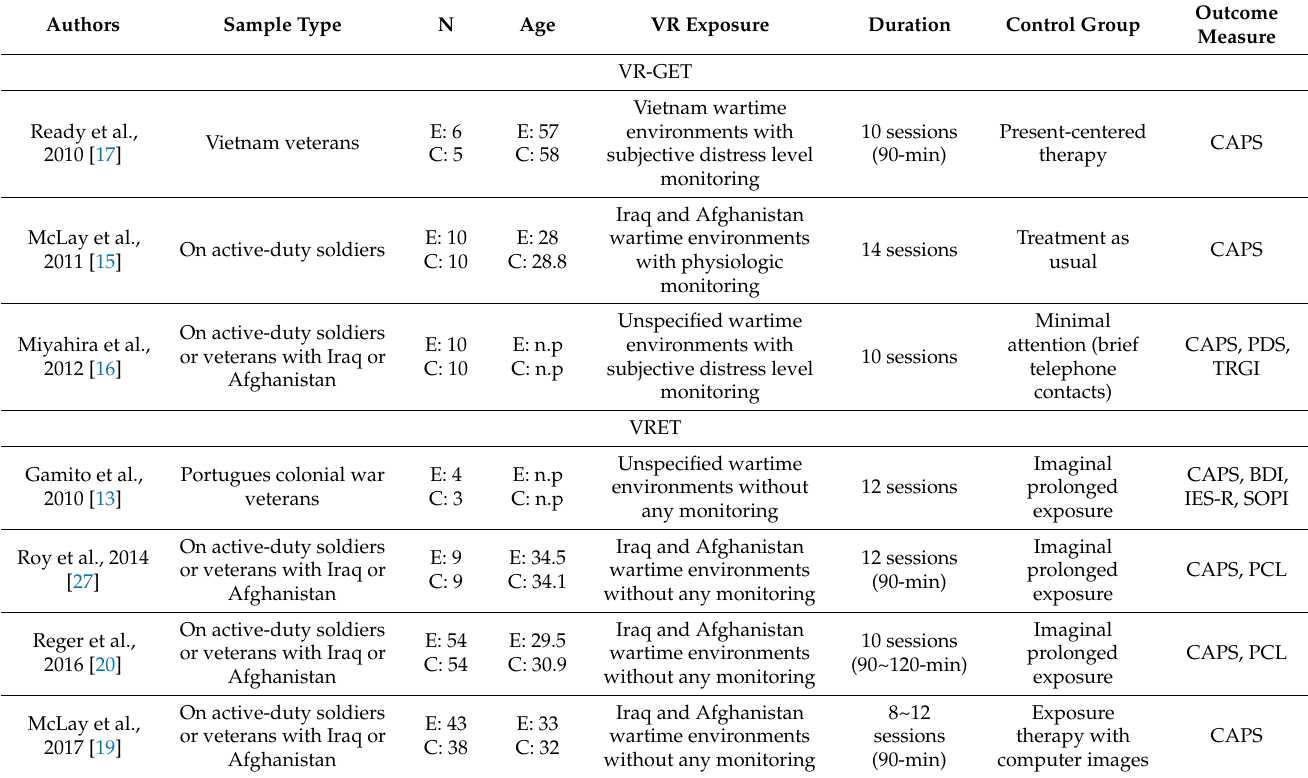
Table 1. Characteristics of the studies included in the systematic review and